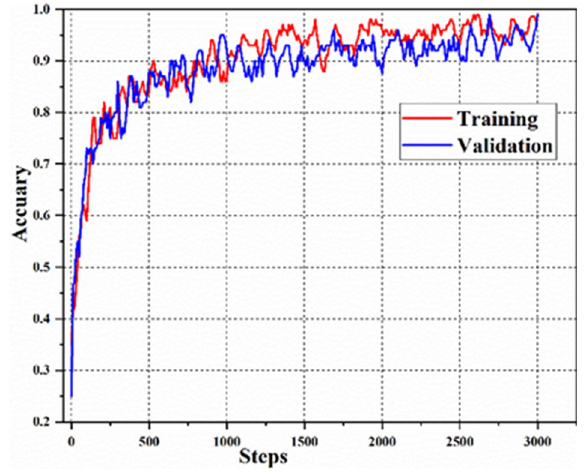
Figure 9. Training and validation accuracy curves of the proposed model.